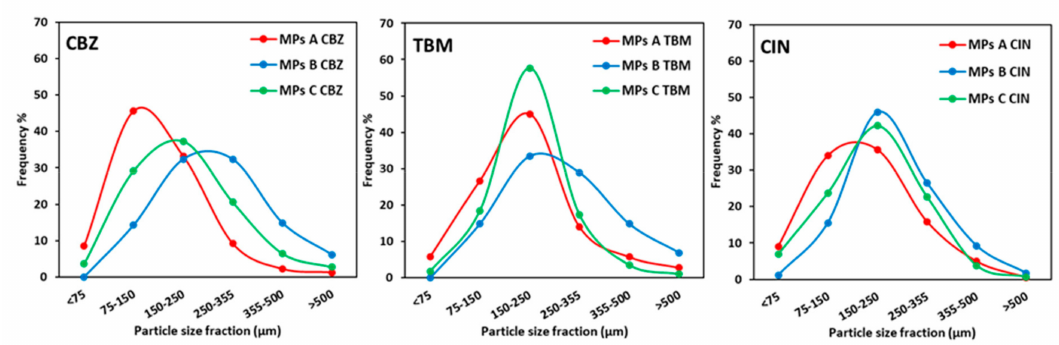
Figure 3. Particle size analysis of MPs A, B, and C loaded with the three model APIs.